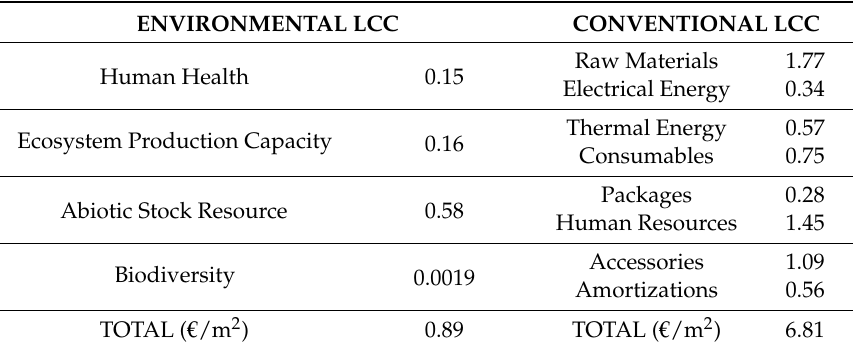
Table 3. Life Cycle Costing (LCC) for 1 m 2 of ceramic